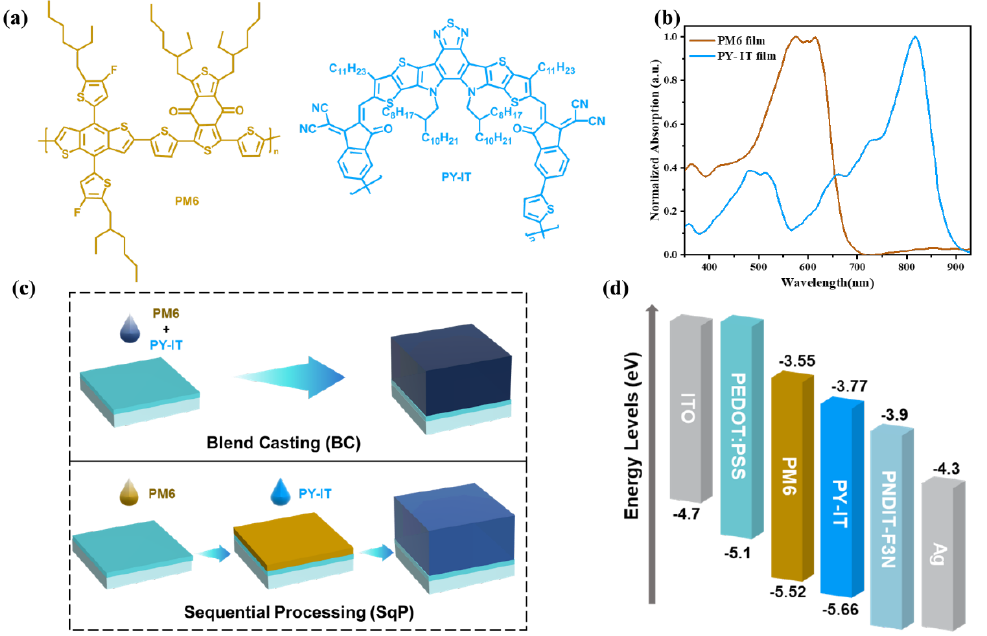
Figure 1. ( a ) Chemical structures of the materials. ( b ) UV ‐ Vis absorption spectra of thin films. ( c ) Schematic diagram of blend ‐ casting and sequential processing. ( d ) Energy level diagram of polymers. The bottom and top of the bar represent HOMO and LUMO, respectively.